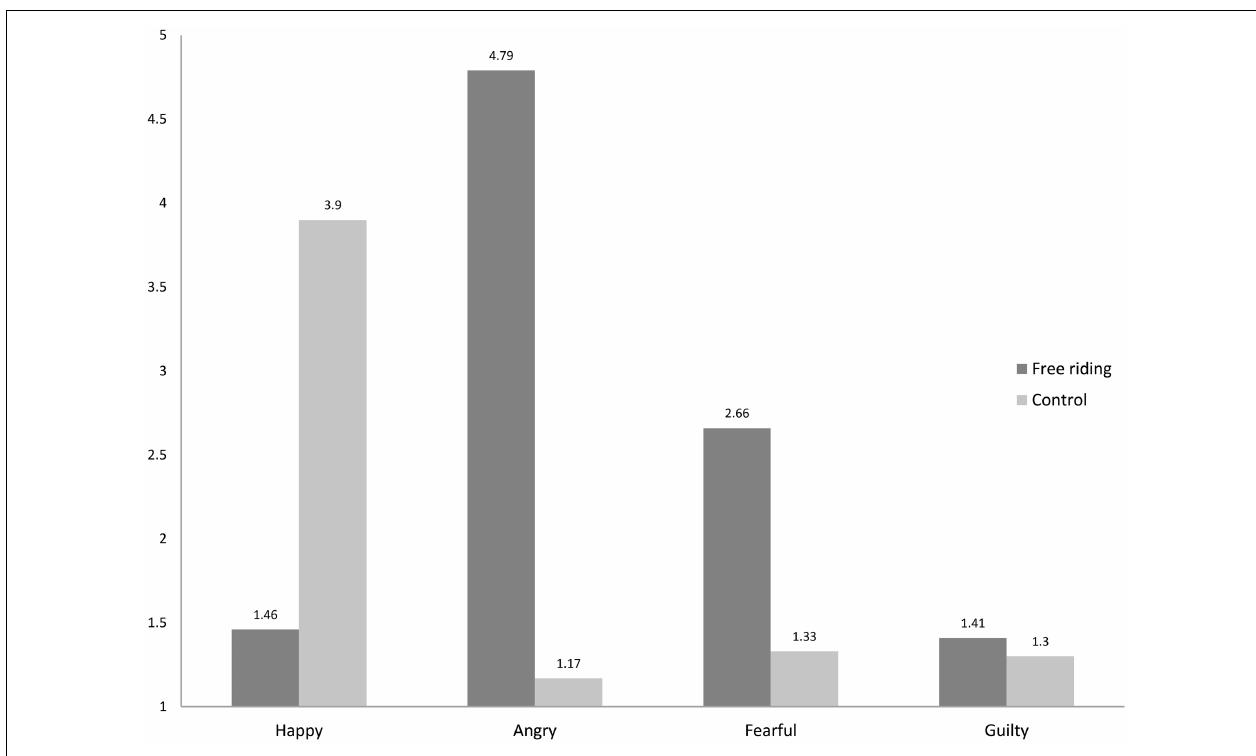
FIGURE 2 | Means of positive and negative emotions in the free-riding and the control (no free-riding) conditions .